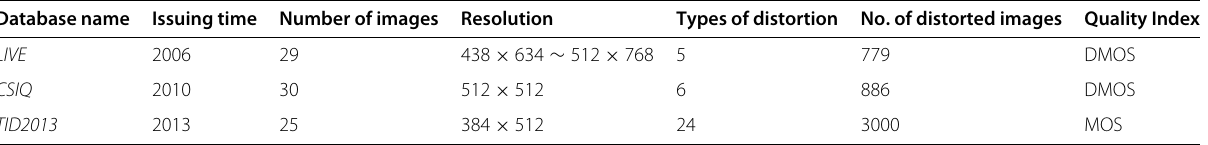
Table 3 Comparison of basic database